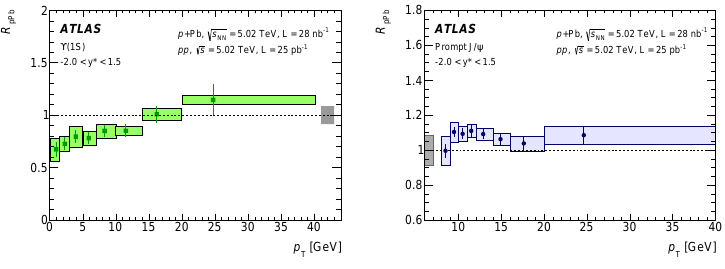
Figure 5. Nuclear modification factor as a function of p T for (left) Υ (1S) and (right) prompt J /ψ production. Figures are taken from Ref. [5].